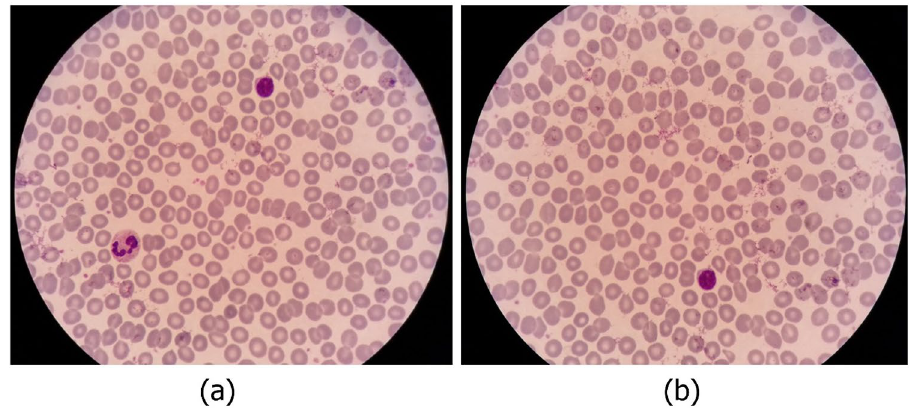
Figure 5. An example of two overlapped microscopic images.